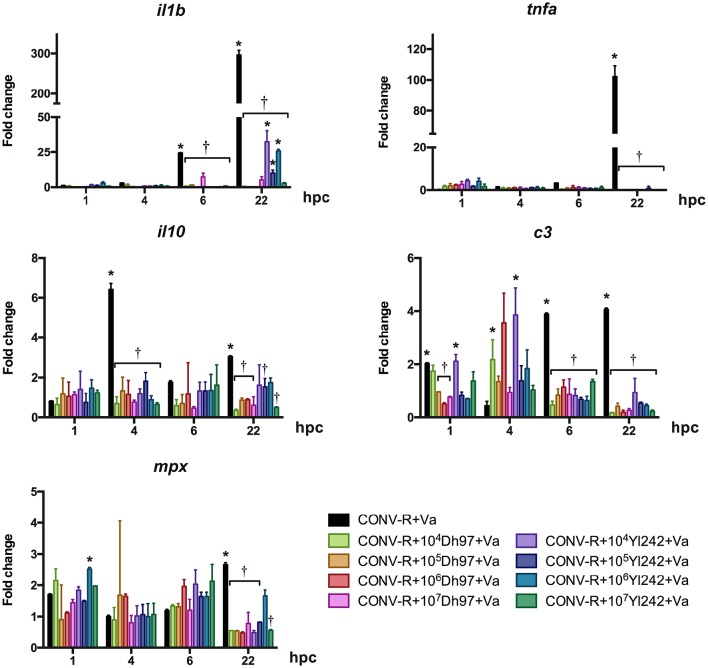
Expression of innate immune genes analyzed by qPCR in conventionally raised (CONV-R) larvae challenged with V. anguillarum at 5 dpf, pre-treated at 4 dpf with different concentrations of each yeast, relative to non-challenged CONV-R larvae. Dh97, Debaryomyces hansenii 97; Yl242, Yarrowia lipolytica 242; il1b, interleukin 1 beta; tnfa, tumor necrosis factor a; c3, complement component 3; mpx, myeloid-specific peroxidase; il10, interleukin 10; hpc, hours post V. anguillarum-challenge. Data were normalized to beta actin 1. The results show the mean ± SD of 3 independent experiments with three replicates each. *Indicates statistically significant differences of the experimental groups with non-challenged CONV-R larvae, †Indicates statistically significant differences of the V. anguillarum-challenged larvae treated with yeasts (CONV-R + yeast + Va) with V. anguillarum-challenged CONV-R larvae (CONV-R + Va).